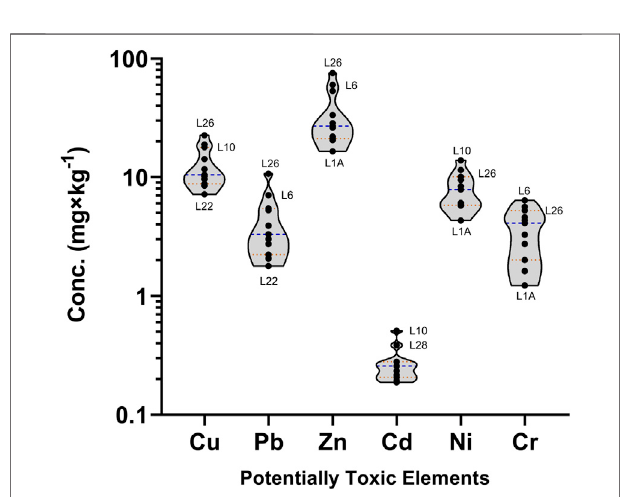
FIGURE 5 | Content of Potentially Toxic Elements in soil of Livingston Island, mg × kg − 1 .